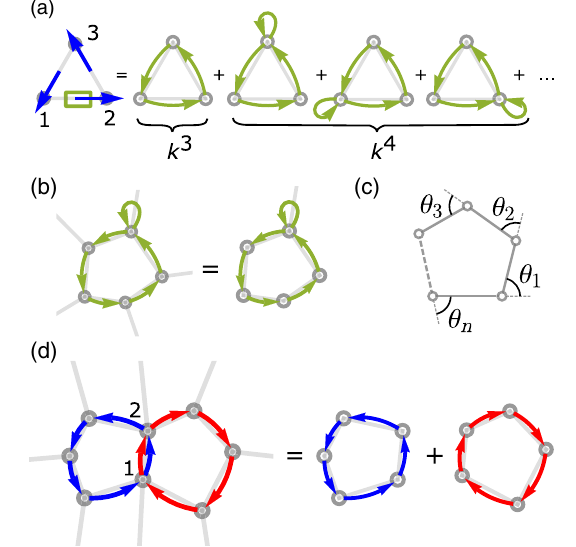
FIG. 3. Illustrations of our diagrammatic technique. (a) Flux from site 1 to site 2 can be calculated by summing over diagrams. Each diagram is a closed path, which pictorially represents one term in the small- k expansion. Paths are depicted using green arrows. The magnitude of the path of length n is on the order of k n . (b) A useful property of the diagram is that if there is no loop on a node, then the diagram can be simplified by removing all other branches on the node. (c) Schematic of a polygon path and its outer angles θ 1 ; θ 2 ; … ; θ . The value of this diagram is written n in Eq. (12). (d) The lowest-order flux from 1 to 2 in complex networks is the sum over the shortest cycles that contain 1 → 2 , which in this schematic are two pentagon diagrams ( k 5 ). If, for instance, one of the pentagons is replaced by a triangle, then the triangle diagram ( k 3 ) dominates the flux from 1 to